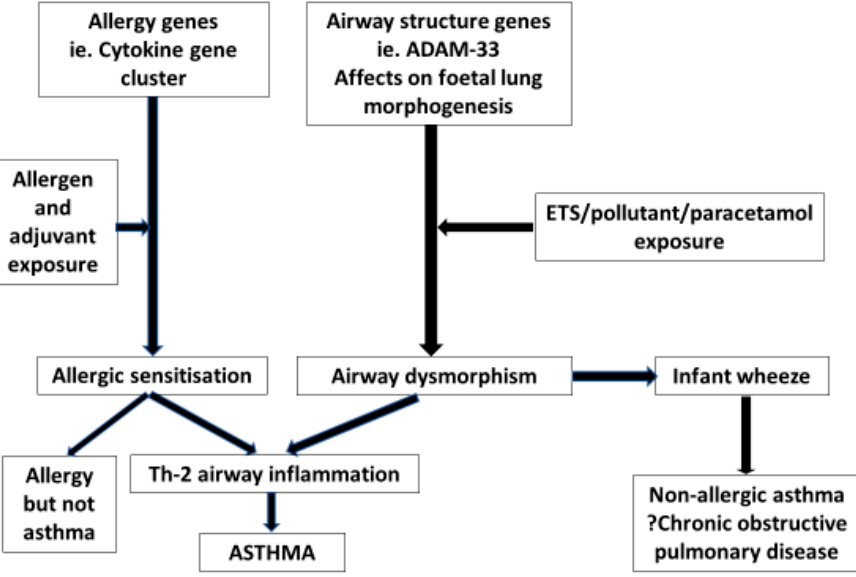
Figure 4. An algorithm of the distinct effects of gene/environment interactions increasing risks of airway dymorphisms and/or allergic sensitisation. When combined they lead to the development of allergic asthma. Isolated airway dysmorphisms increase the risks of infant wheeze and also chronic obstructive pulmonary disease. Arrows indicate the direction of